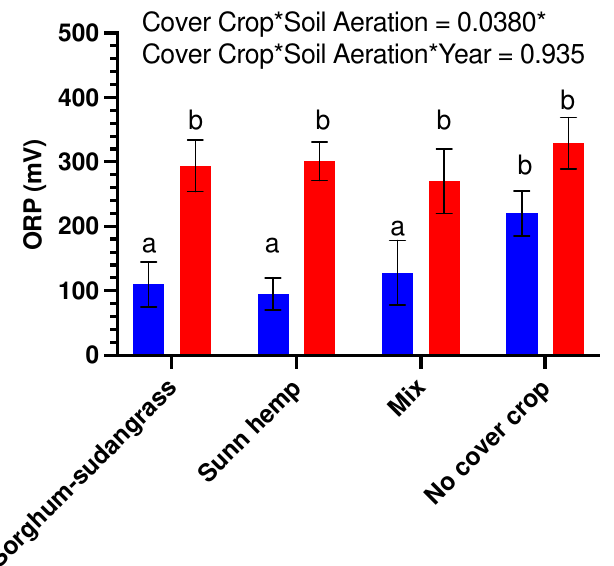
Figure 2. A verage soil ORP (oxidation-reduction potential) in 2020 and 2021 field trials over a 4-week ASD period in field plots amended with cover crops [sorghum-sudangrass, sunn hemp, mix (sorghum-sudangrass + sunn hemp)] in two soil conditions (non-aerated or aerated). Data are pooled for both years because there was no cover crop*soil aeration*year interaction; (*) in text indicate interaction and on p values indicate significant effects. Data are expressed as mean ± SD (n = 8); bars with the same letter indicate the means are not significantly different based on the least significant difference (LSD) test (p < 0.05). The experiment was conducted at the organic research farm,